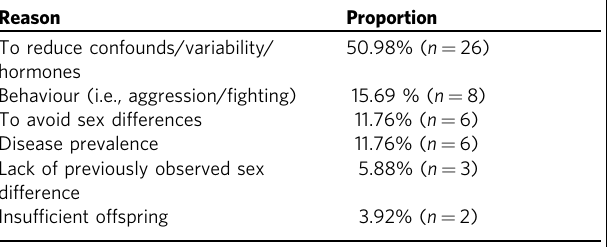
Table 3 Thematic rationales given in papers sampled that had studies that included one sex in study